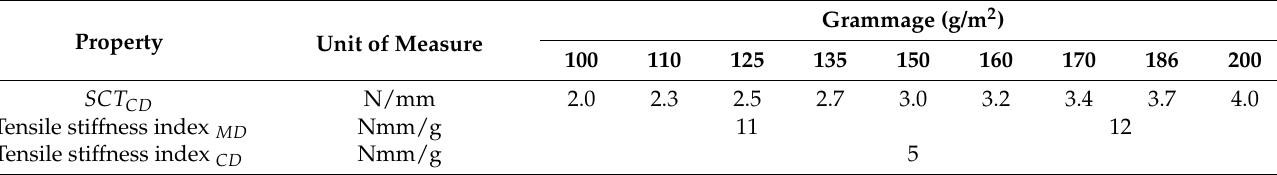
Table 1. MONDI technical data for kraftliner paper.